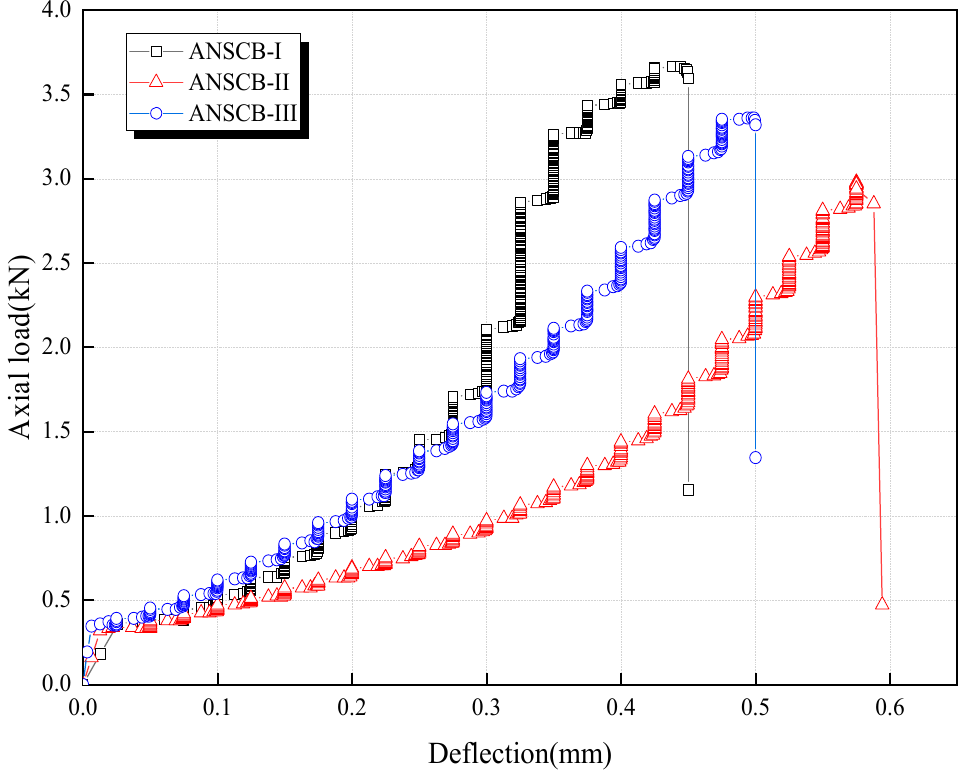
Figure 3. The load-deflection curves and peak loads of different ANSCB